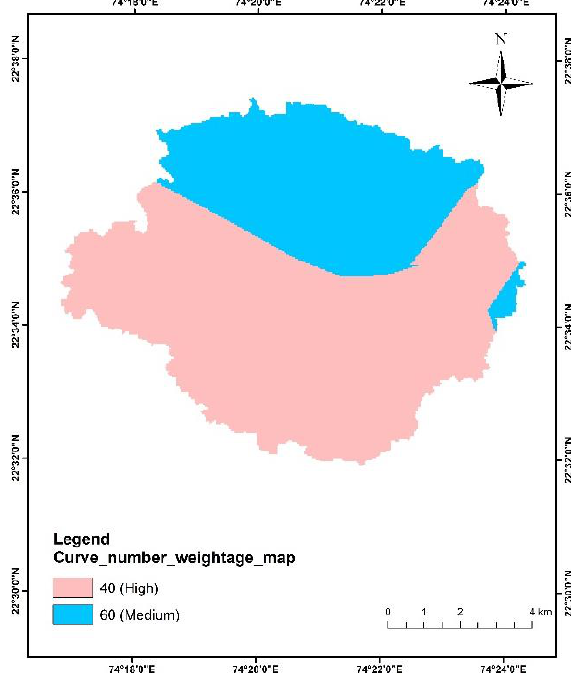
Figure 10. Curve number weightage